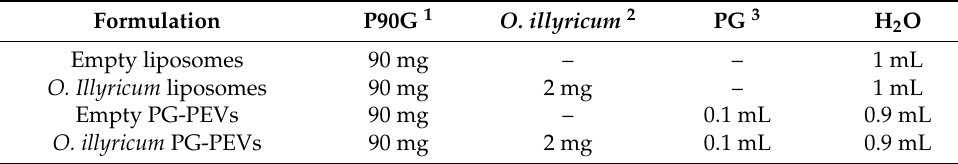
Table 7. Composition of the vesicle formulations. Formulation P90G